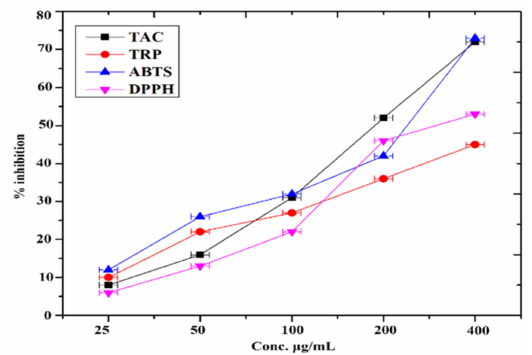
Figure 6. Antioxidant potential of synthesized of